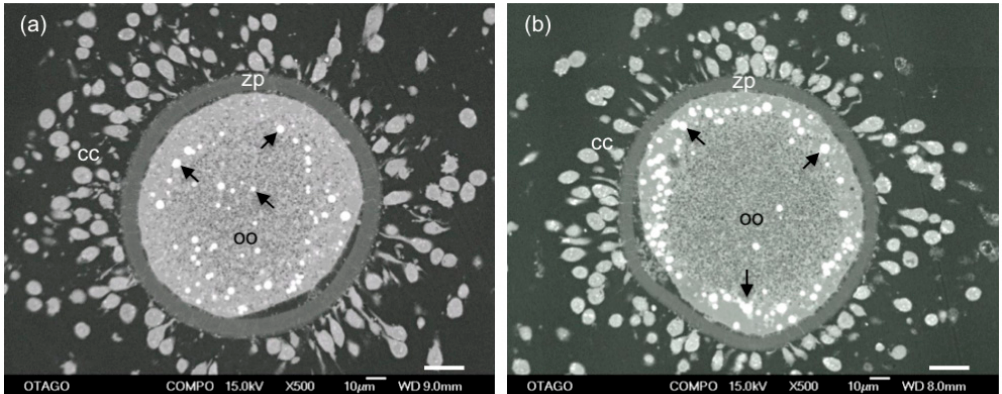
Figure 3. SEM images of lipid distribution in mature sheep oocytes (oo) surrounded by zona pellucida (zp) and expanded cumulus cells (cc). Lipid droplets (arrows) are either distributed: throughout the cytoplasm ( a ); or in a peripheral location ( b ). A higher proportion of oocytes from adult sheep had evenly distributed lipid droplets than those from prepubertal sheep that had predominantly peripherally located droplets. Scale bar = 20 μ m.